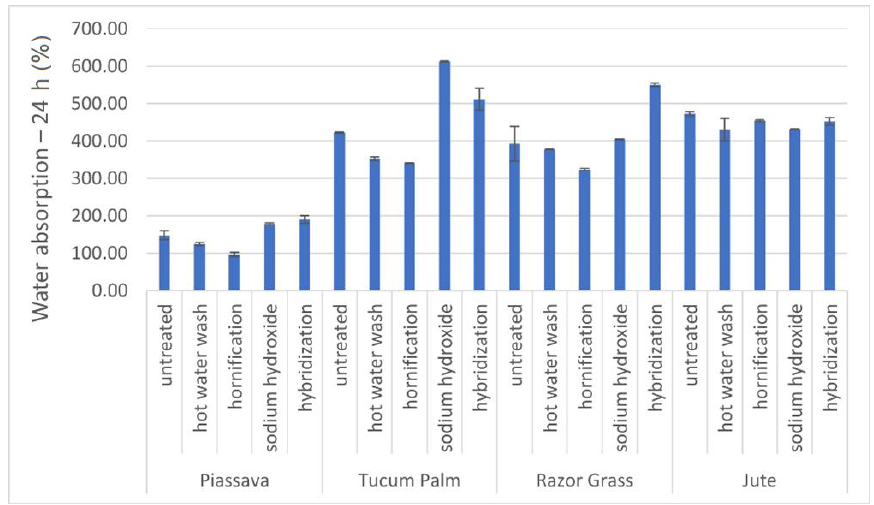
Figure 2. Water absorption — 24 h of treated fibers compared with untreated. Four fibers: piassava, tucum palm, razor grass, and jute. (N = 3).